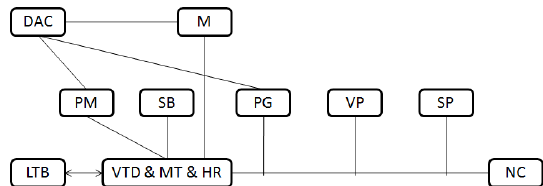
Figure 6. Apparatus scheme of density measuring for R227ea [1]. VTD represents the vibrating tube densimeter; PM represents the frequency meter; DAC represents the data acquisition and control; MT represents the temperature measurement sensor; M represents the multi-meter; LTB represents the liquid thermostatic bath; HR represents the heating resistance; SB represents the sample bottle; PG represents the pressure gauge; VP represents the vacuum pump; SP represents the syringe pump; NC represents the cylinder.